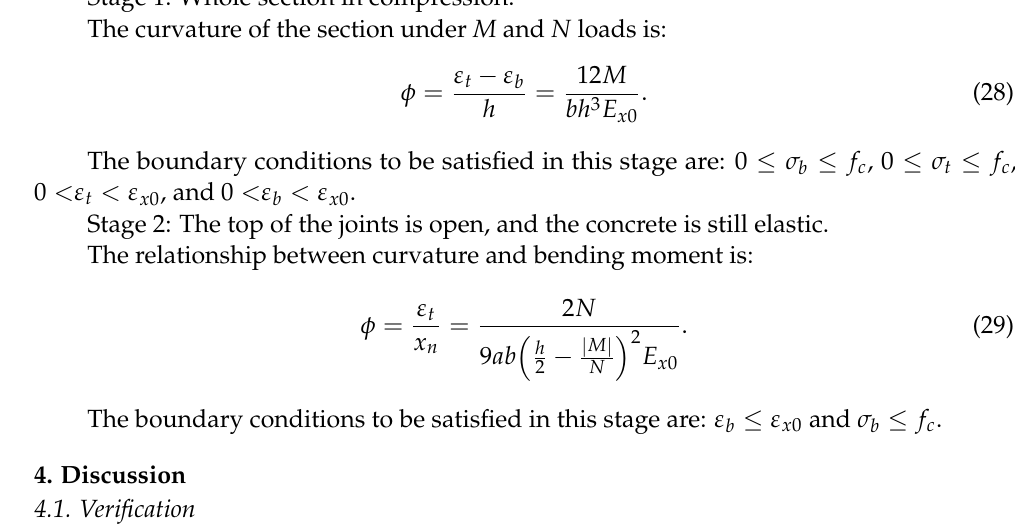
Table 2. Mechanical parameters of the segment material.